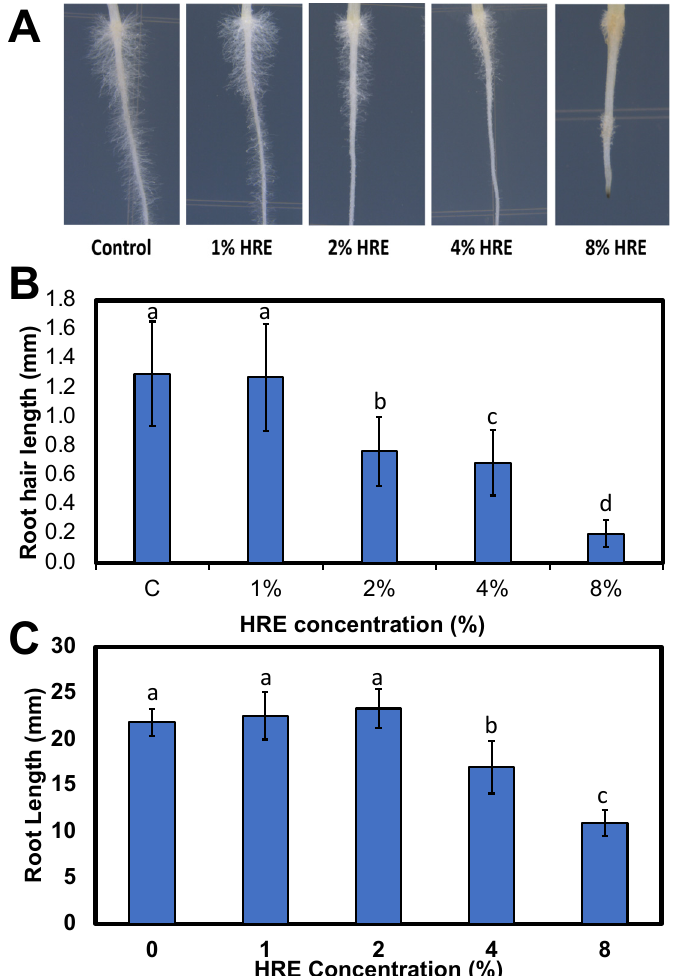
Figure 5. Lettuce root photo ( A ), root hair length ( B ), and root length ( C ) after applying using various concentrations of horseradish extract (0, 1, 2, 4, and 8% aqueous extract) for 3 days. “Grand Rapids TBR” lettuce seeds ( Lactuca sativa ) were sown on 1.5% w / v agar on square petri dishes. There were 4 treatment groups each consisting of 3 Petri dishes ( N = 60 seeds). Petri dishes were sealed with Parafilm to keep the volatile compounds after applying with 1 mL of either deionized distilled water for control or 1%, 2%, 4%, or 8% HRE for treatment. Different lowercase letters indicate significant difference at p < 0.05 by least significant difference.